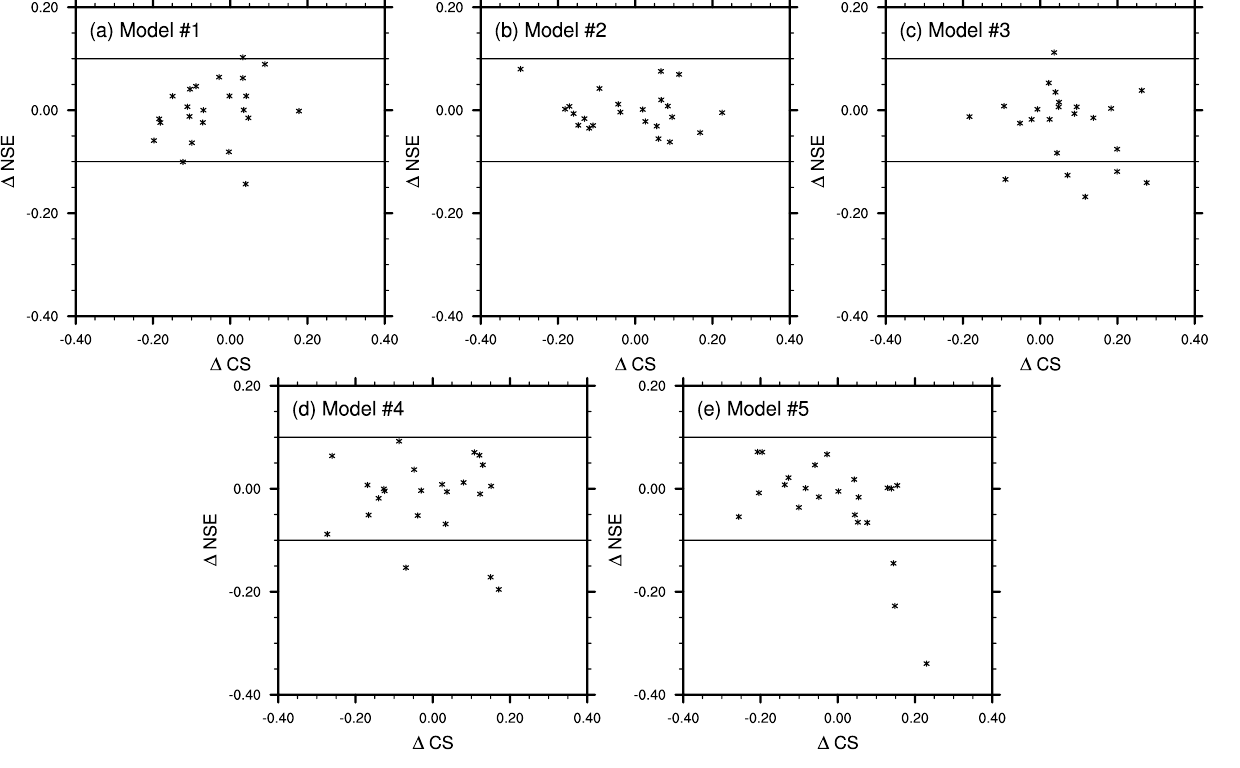
Figure 8. Relationship between ∆ CS (i.e., the GBRT-estimated CS minus the calibrated CS ) and ∆ NSE (i.e., the GBRT-estimated NSE minus the calibrated NSE) in five different GBRT models. ( a ): Model #1; ( b ): Model #2; ( c ): Model #3; ( d ): Model #4; ( e ): Model